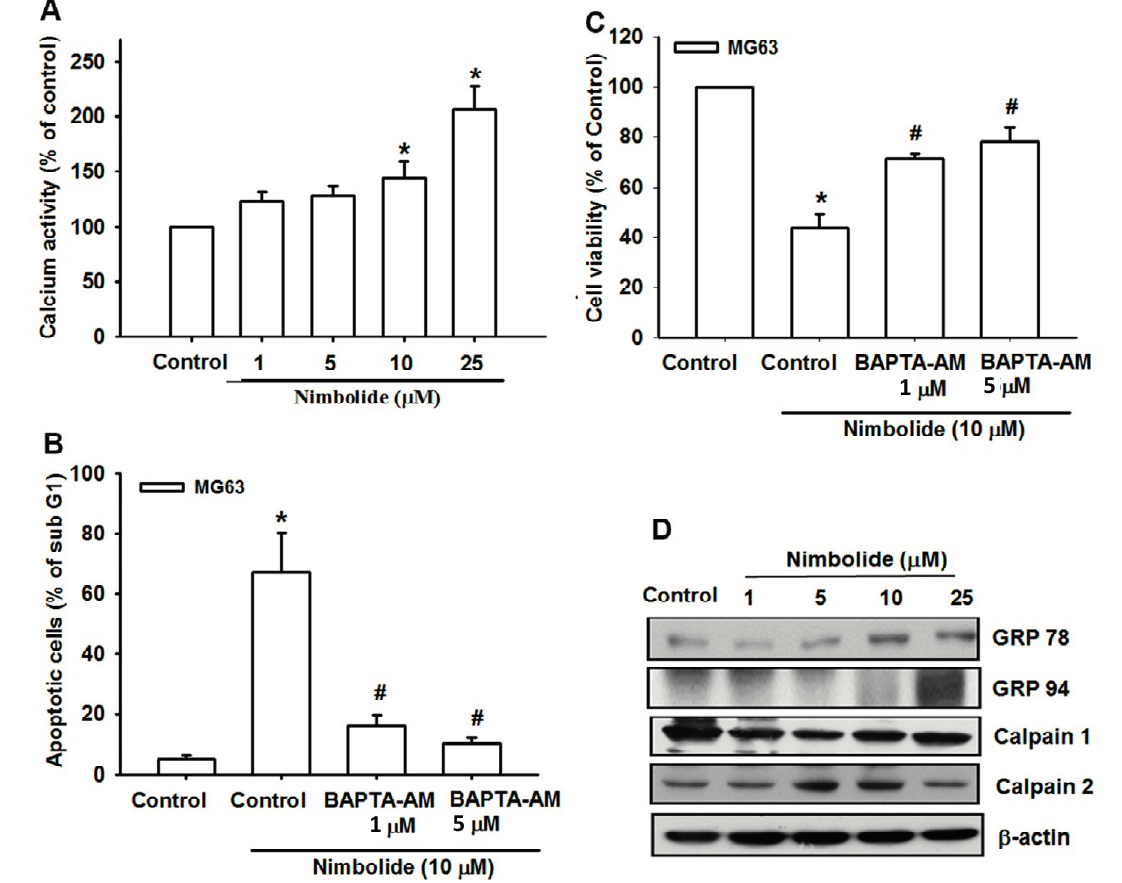
Figure 3. Nimbolide induces Ca 2+ release and ER stress in human osteosarcoma cells. ( A ) MG63 cells were treated with control solution or various concentrations of Nimbolide for 24 h. Ca 2+ release was examined by using flow cytometry; ( B ) MG63 cells were (10 μ M) for 24 h. The percentage of apoptotic cells was then analyzed by flow